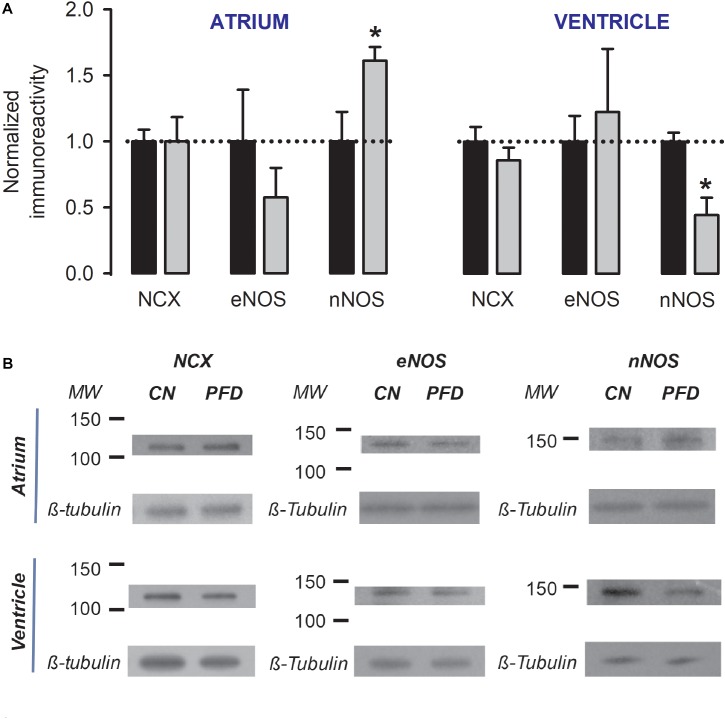
Dual regulation of nNOS expression by PFD. (A) Normalized immunoreactivity that was detected in myocytes exposed to primary antibodies against NCX, eNOS, and nNOS (β-tubulin was the loading control). Bars represent the average values from a total of three to four independent experiments. ∗p < 0.05. (B) Examples of western blots that were analyzed to generate data shown in (A).